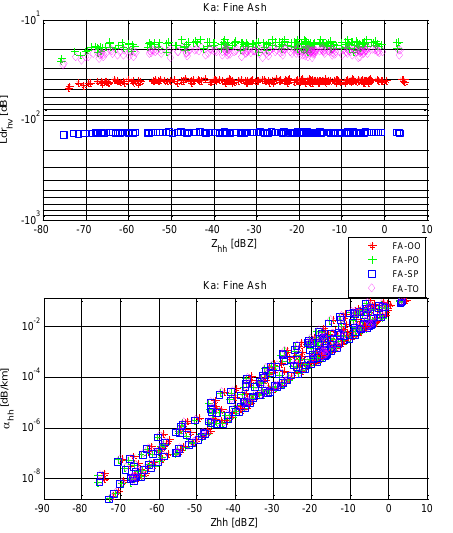
Figure 1a: Correlation between zenith Ka-band polarimetric radar observables in terms of copolar reflectivity Z hh (36GHz), linear depolarization ratio L dr (36GHz), and specific attenuation  hh (36GHz) for FA size class, using all ash concentrations classes (VC, SC, MC and IC) and for different particle orientations (OO, PO, SP and TO.2) with basaltic axial ratio